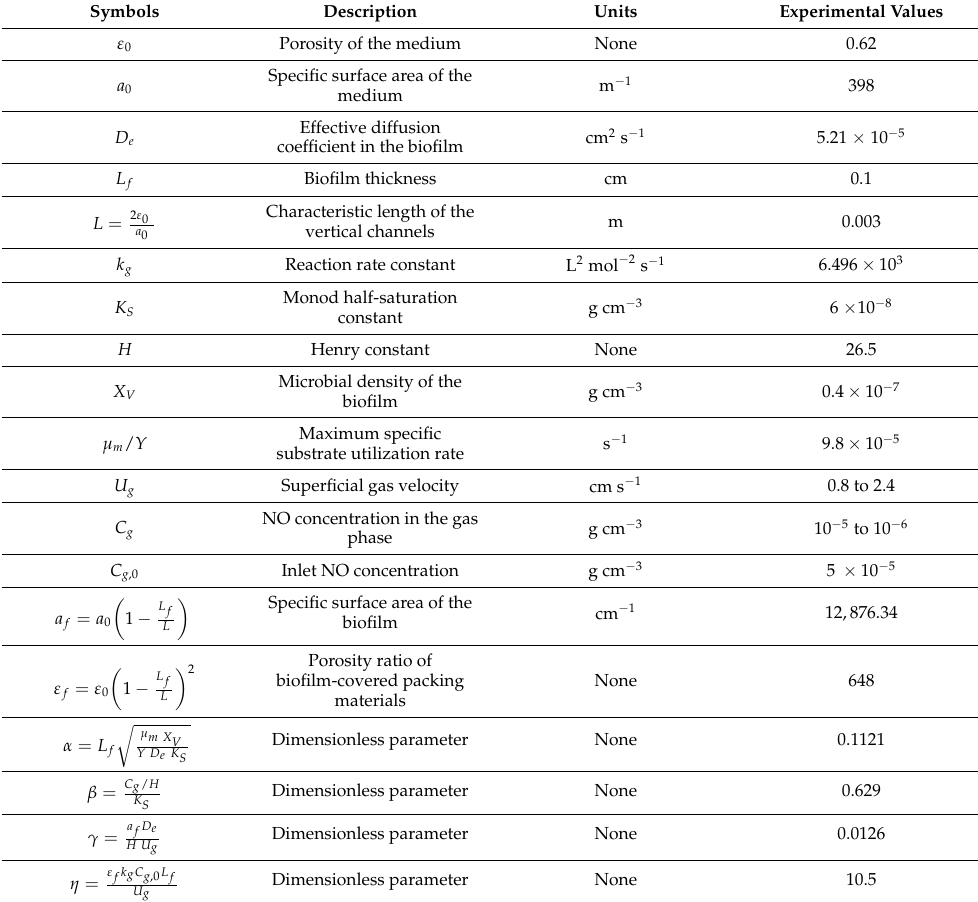
Table A1. Experimental Value of the Parameters [13] Used in This Work (Figure